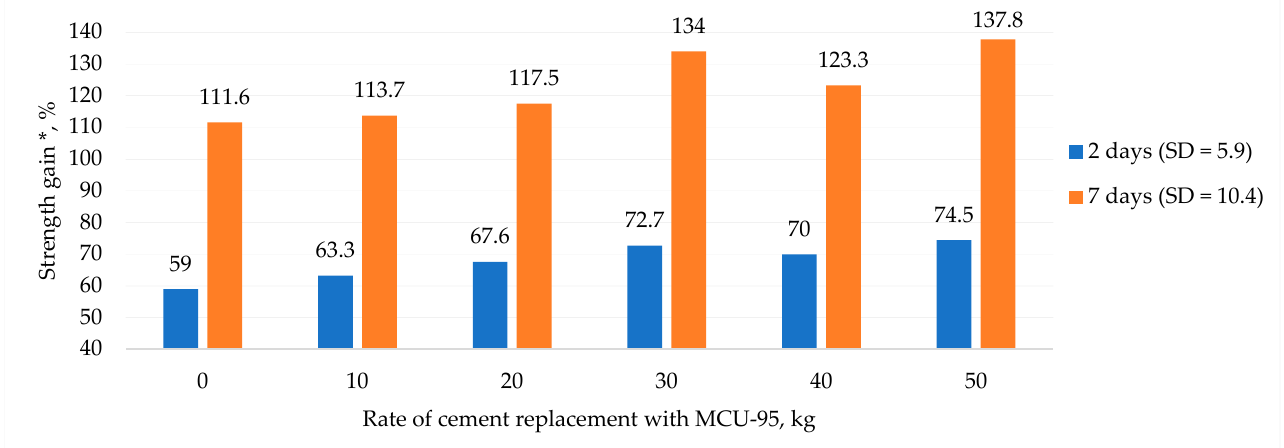
Figure 3. Microstructure of a fracture of the RHC sample containing MCU-95.